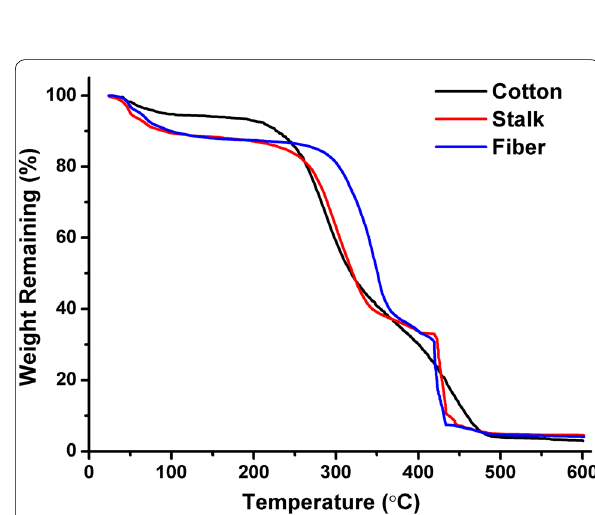
Fig. 3 TGA curves for the thermal degradation of M. pinnata stalks and extracted fibers compared with cotton